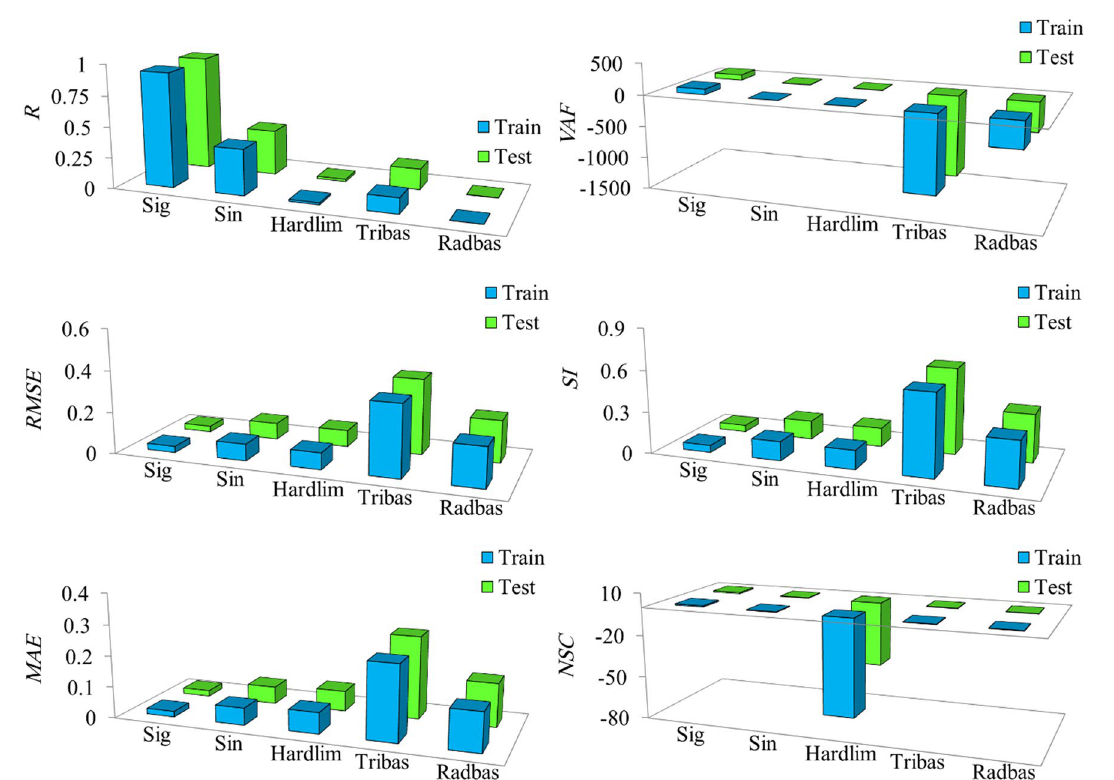
Fig. 6 Outcomes of statistical indices acquired in both modes for different activation